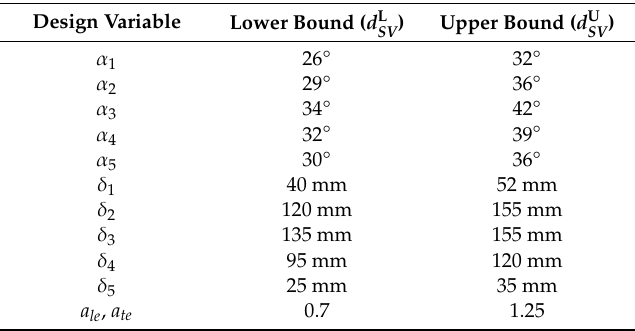
Table 4. Bounds for design variables of stay vane.